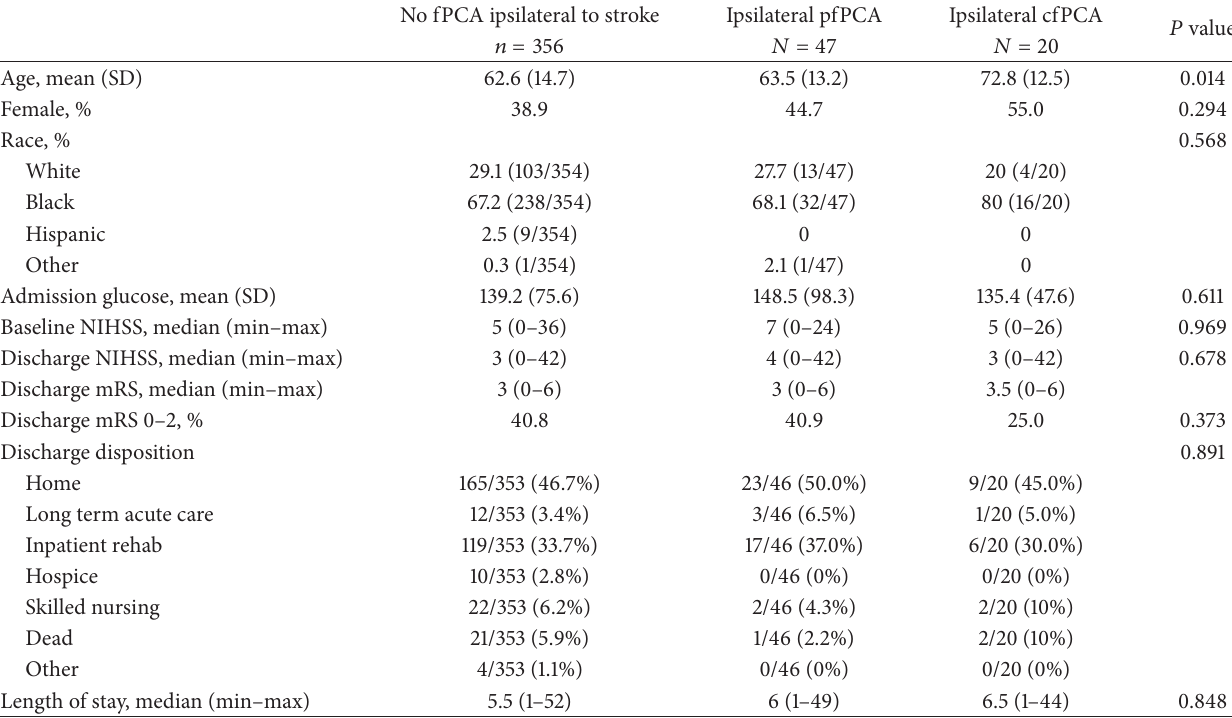
Table 4: Demographics, vascular risk factors, and outcome in patients without fetal PCA (no fPCA), ipsilateral partial fetal PCA (pfPCA), and ipsilateral complete fetal PCA